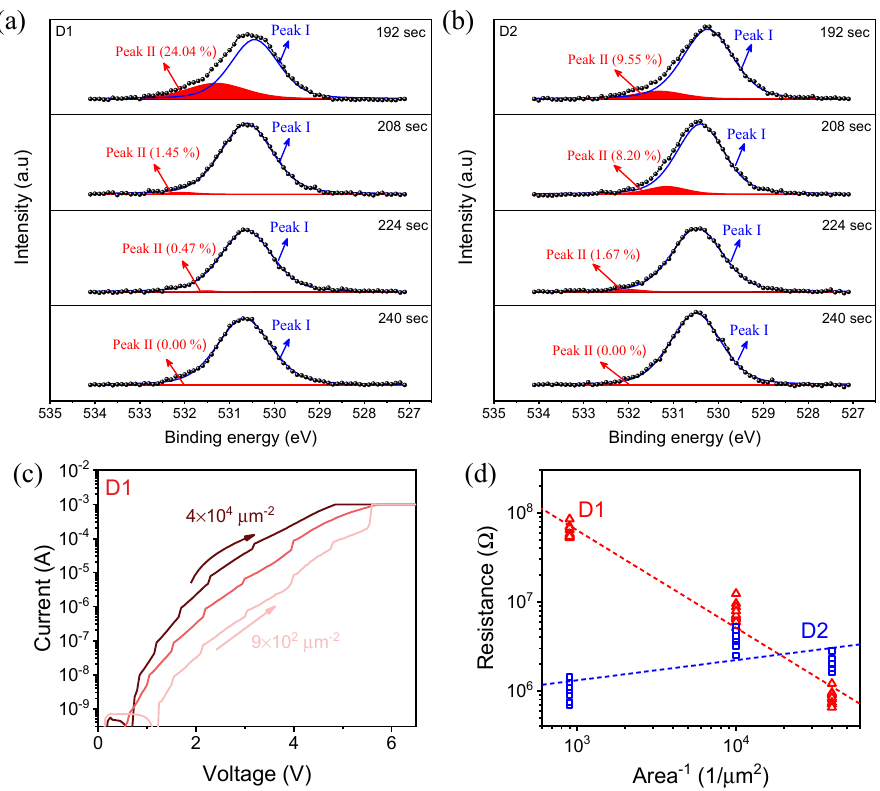
Figure 4. O 1s spectra of ( a ) the D1 device and ( b ) the D2 device. 192/208/224/240 s indicate the region of SnO X and each peak corresponds to the metal-oxide bonding and the oxygen vacancies. ( c ) Forming curves of the D1 device measured in different electrode areas. ( d ) Area-dependent property under the effect of oxygen plasma treatment; 10 different cells in each area were